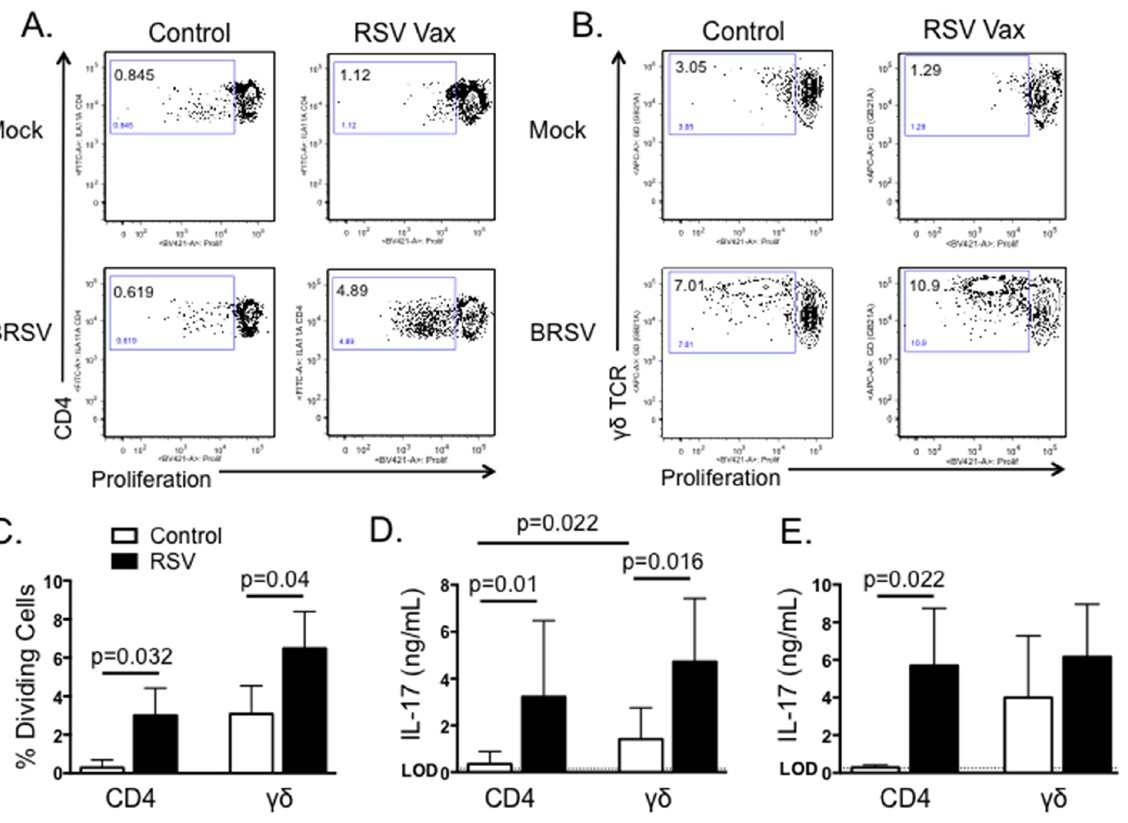
Fig 4. Both CD4 T cells and γδ T cells produce IL-17 in response to BRSV. PBMC were isolated from control or BRSV vaccinated cows and labeled with Cell Trace Violet. Cells were then cultured for 6 days with BRSV. On day 6, CD4 T cells (A) and γδ T cells (B) were analyzed for virus-specific proliferation as measured by Cell Trace Violet dilution. Representative flow plots are shown in A and B. Aggregate results are shown in C. (D) CD4 T cells and γδ T cells from BRSV vaccinated or nonvaccinated animals were isolated by MACS and cultured in the presence of autologous APC ± BRSV. After 6 days, cell culture supernatants were analyzed by ELISA for IL-17. (E) CD4 T cells and γδ T cells were MACS purified from peripheral blood of calves infected or not with BRSV strain 375 for 7 days. Purified cells were cultured in the presence of autologous APC ± BRSV. After 6 days, cell culture supernatants were analyzed by ELISA for IL-17. For A-C, background levels of proliferation were subtracted and results are presented as change over mock. Results are pooled from two independent experiments. Data represent means ± SEM.